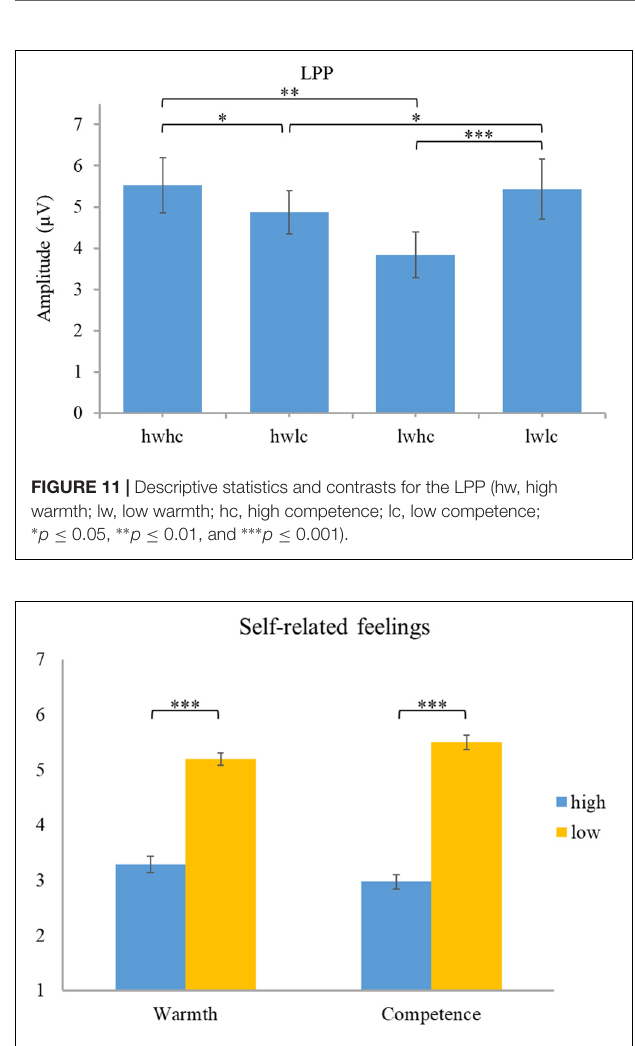
FIGURE 12 | Descriptive statistics and contrasts for self-reported feelings ( ∗∗∗ p ≤